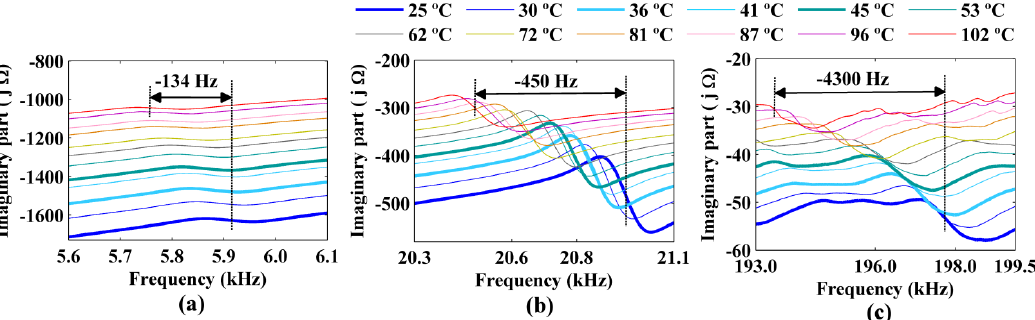
Figure 11. Frequency shifts of the imaginary part of the impedance signatures for resonance peaks at ( a ) 5.91 kHz; ( b ) 20.95 kHz; and ( c ) 197.80 kHz considering the temperature at 25 °C as a